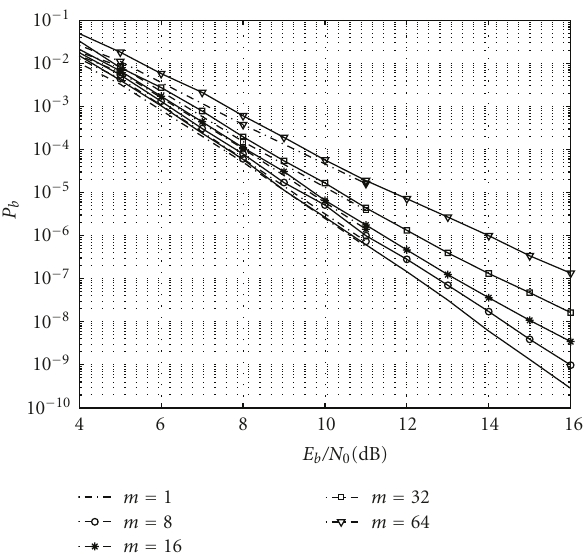
Figure 4: Performance of a convolutionally coded FHSS system over Nakagami fading with perfect CSI for di ff erent hop lengths m and SIR = 5dB, (solid: K = 1, dashed: K = 40).